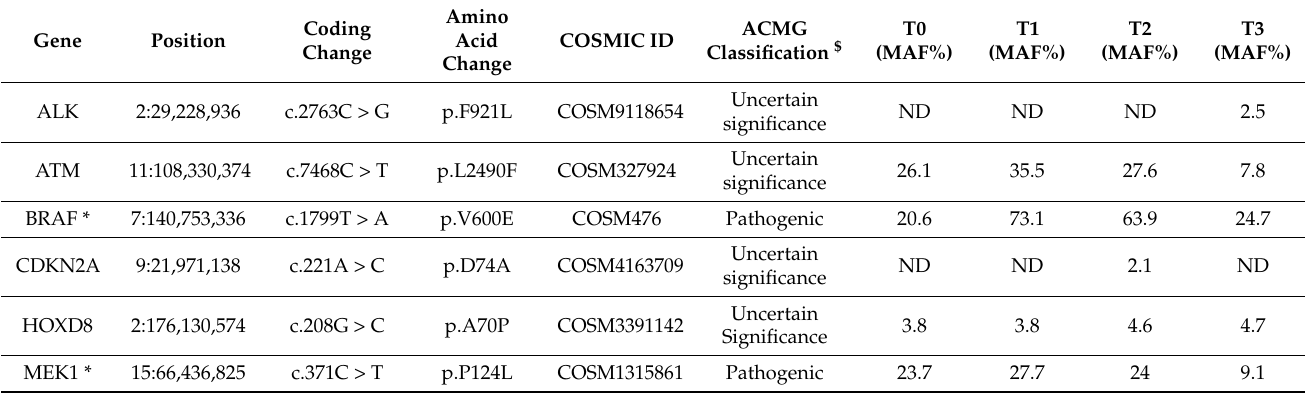
Table 1. ctDNA SNVs detected by NGS at the four time points.